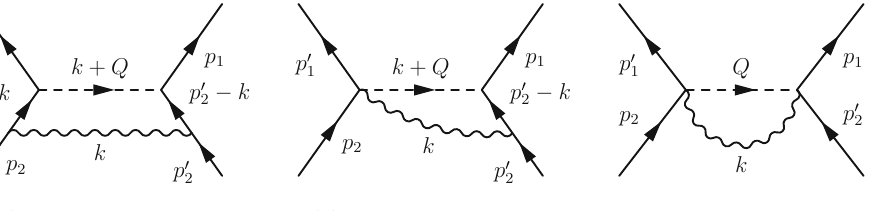
Fig. 9 Box diagrams